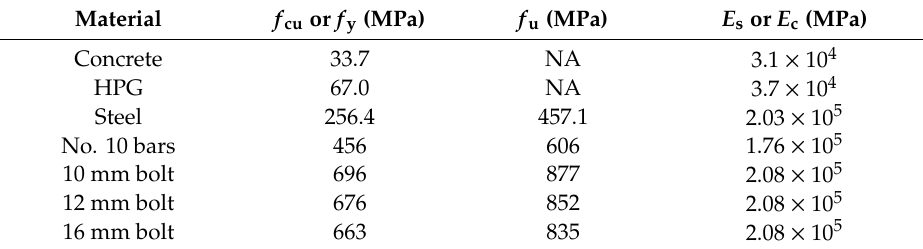
Table 2. Table 2. Material properties of concrete, steel, and Table 2. Material properties of concrete, steel, and bolt.